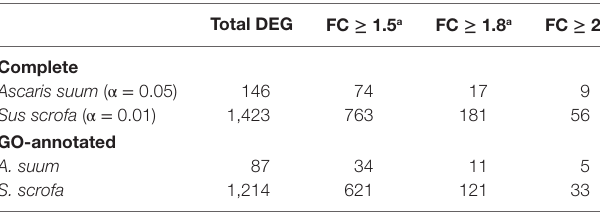
TaBle 1 | Numbers of differentially expressed and annotated genes.